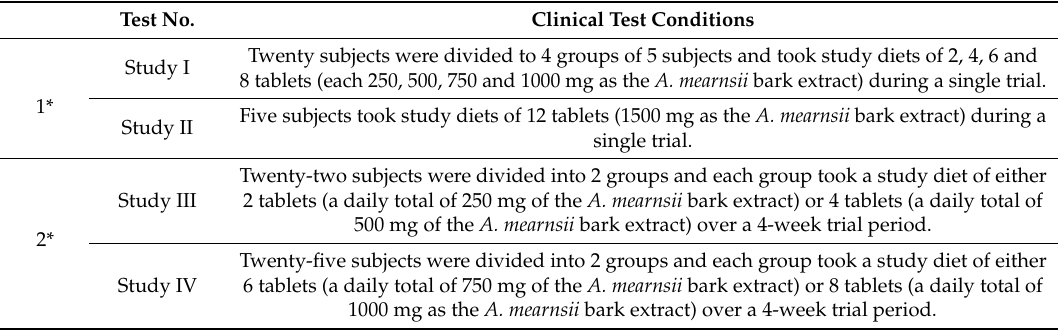
Table 1. Clinical test conditions of four different